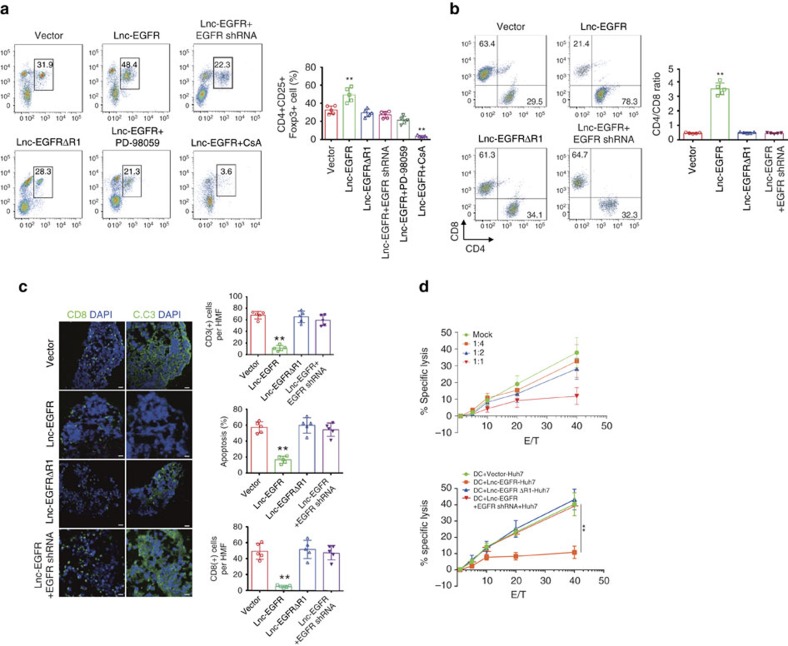
Lnc-EGFR promotes iTreg differentiation and inhibits CTL activity in vitro.(a) Different percentages of Tregs in T cells transduced with lnc-EGFR alone or combined with EGFR shRNA lentiviral particles in the presence or absence of PD98059 (40 μM), or CsA(1 μM), or transduced with lnc-EGFRΔR1 lentivira particles in a Treg cell polarization stimulation assay (with 2 ng ml−1 TGF-β). Quantitative results are shown on the right (n=6 for each group, Student’s t-test). (b) CTL suppression assay of lnc-EGFR was performed in a mixed culture of various types of CD4+ cells, CD8+ cells and OVA-induced DCs. The initial ratio of CD4+ cells to CD8+ cells was 1:1. The CD4:CD8 ratios are presented in the right panel(n=6 for each group, Student’s t-test). (c) A 3D culture system was used to simulate the tumour microenvironment, composed of a human HCC cell line (97H cells), DCs vaccinated with 97H cell lysate, various CD4+ cells, and CD8+ cells, evaluated with immunofluorescent staining for C.C3. The green stain in the right panel indicates cleaved caspase 3, whereas the green stain in the left panel indicates CD8+ cells. DAPI was used to stain the nuclei. The calculated data are given in the right panel(n=6 for each group, Student’s t-test). (d) The cytolytic activity of the generated CTLs based on different ratios of CD4+ cells was determined in a standard 51Cr-release assay with E: T ratios of 5:1, 10:1, 20:1 and 40:1. The cytolytic activity of the generated CTLs co-cultured with CD4+ cell treated with different groups was detected with a 51Cr-release assay and is presented in the right panel are means±s.e.m. (n=5 each group) (*P<0.05, **P<0.01). Each experiment was performed triplicated.